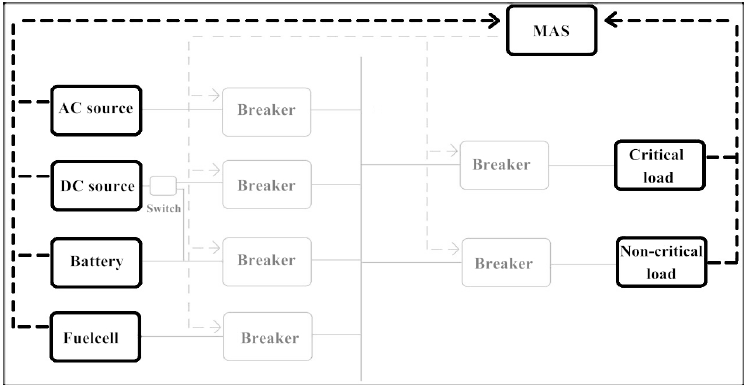
Figure 8. Power and load information collected by the multi-agent system.